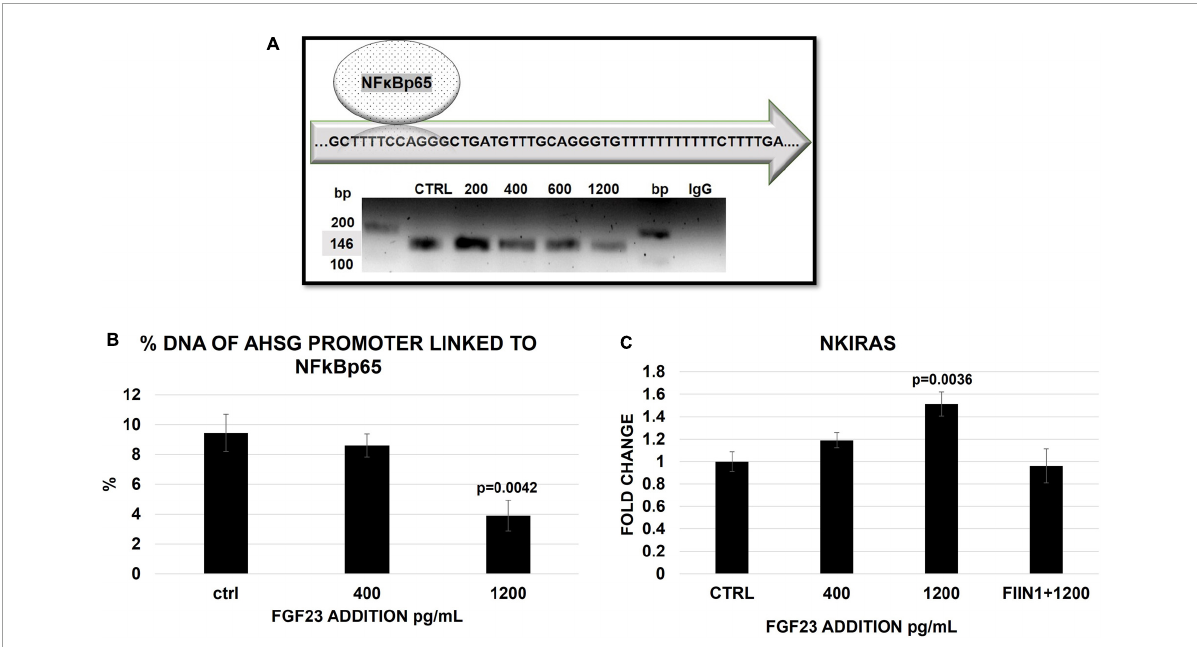
FIGURE4 Semi-quantitative PCR of AHSG promoter (146 bp) in HepG2 IP with ab anti-NF κ B in the ctrl and 24 h after a scalar addition of FGF23 (200–1,200) (A) . The false positivity was excluded by the negative ctrl normal mouse IgG (A) , while the correctness of the PCR was confirmed by the input (10% DNA) in the sample ctrl, 400 and 1,200 pg/ml ( Supplementary Figure 1B ). Percentage of AHSG promoter linked to NF κ B 24 h after a scalar addition (400–1200 pg/ml) of FGF23. Changes of NKIRAS2 mRNA expression 24 h after the addition of FGF23 at 400 pg/ml and at 1,200 pg/ml without and with FIIN 1 hydrochloride (FIIN1) in HepG2. N = 3 (B) , N = 6 (C) .